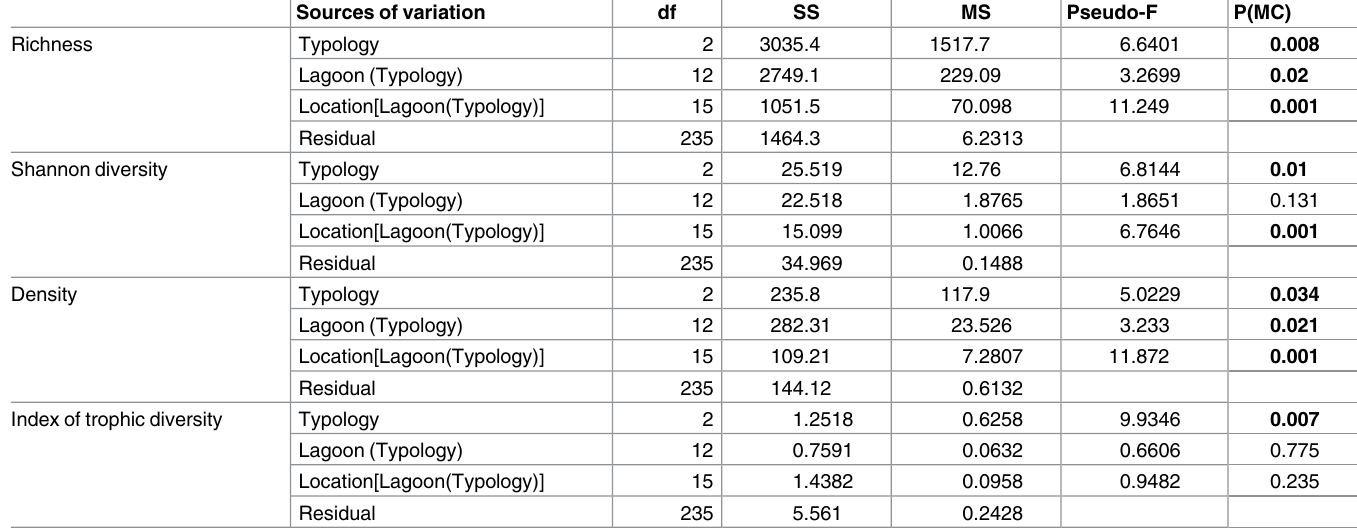
Table 2. Permutational analysis of variance(PERMANOVA) results testing the effectsof lagoon typology (Open, ICCOL and Closed), lagoons (5 open, 5 ICOLL and 5 closed) and location (inner and outer) on the univariate nematode descriptors, feeding types and index of trophic